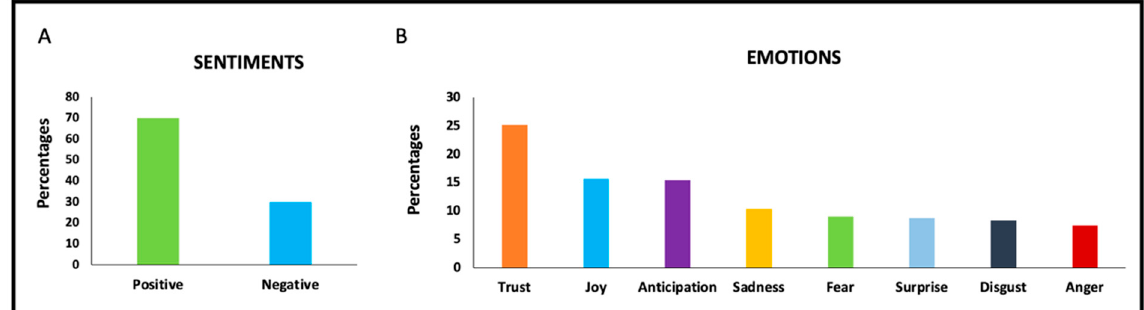
Figure 4. Percentages of sentiments ( A ) and emotions ( B ) of comments in videos.